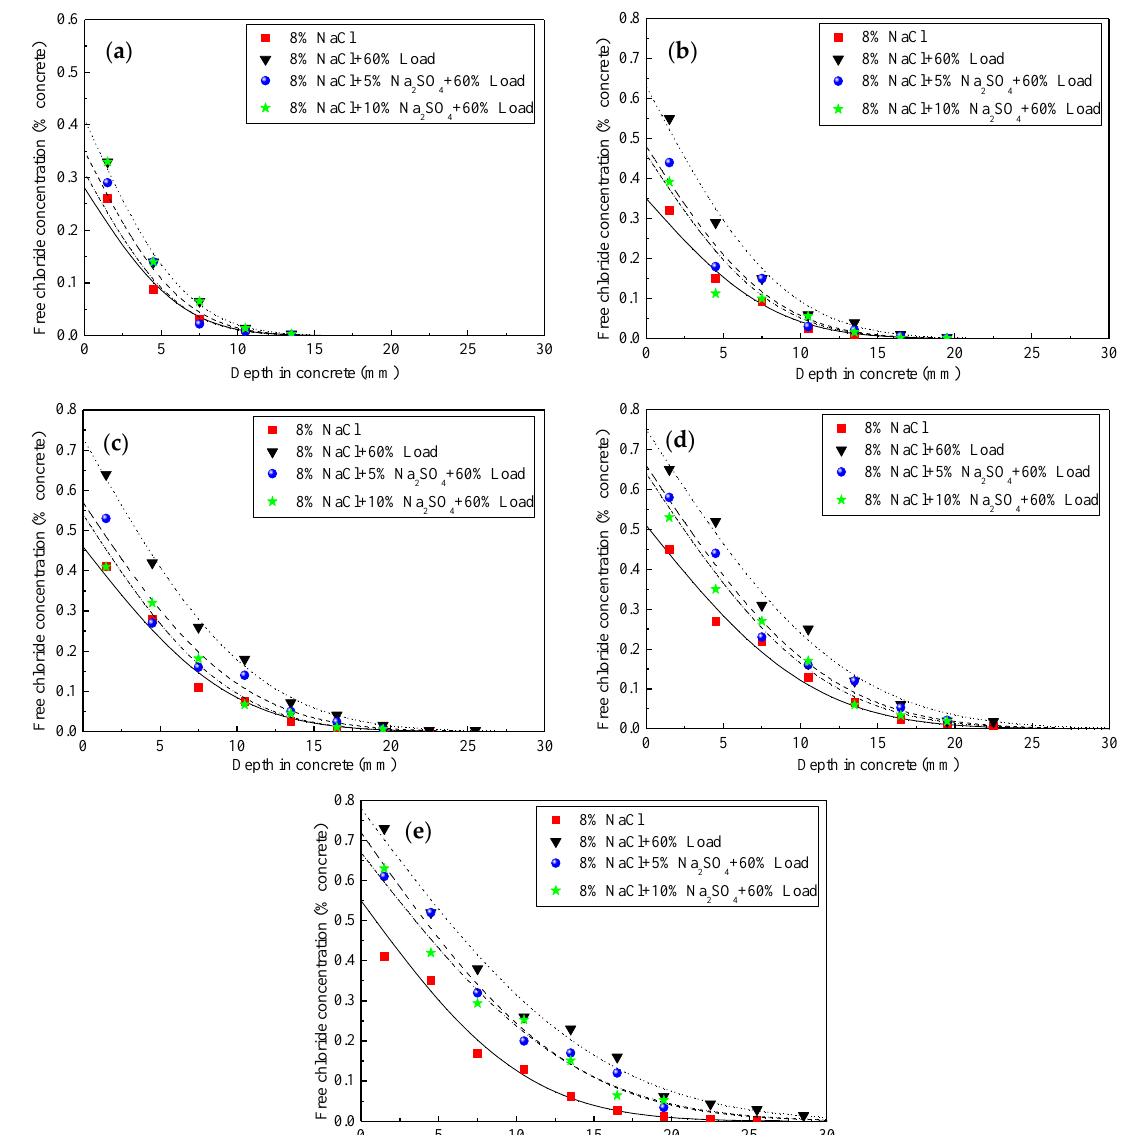
Figure 4. Chloride concentration distribution of concrete immersed in different sodium sulfate and sodium chloride coupling of cyclic loading condition. ( a ) 20 d; ( b ) 40 d; ( c ) 60 d; ( d ) 80 d; ( e ) 100 d.